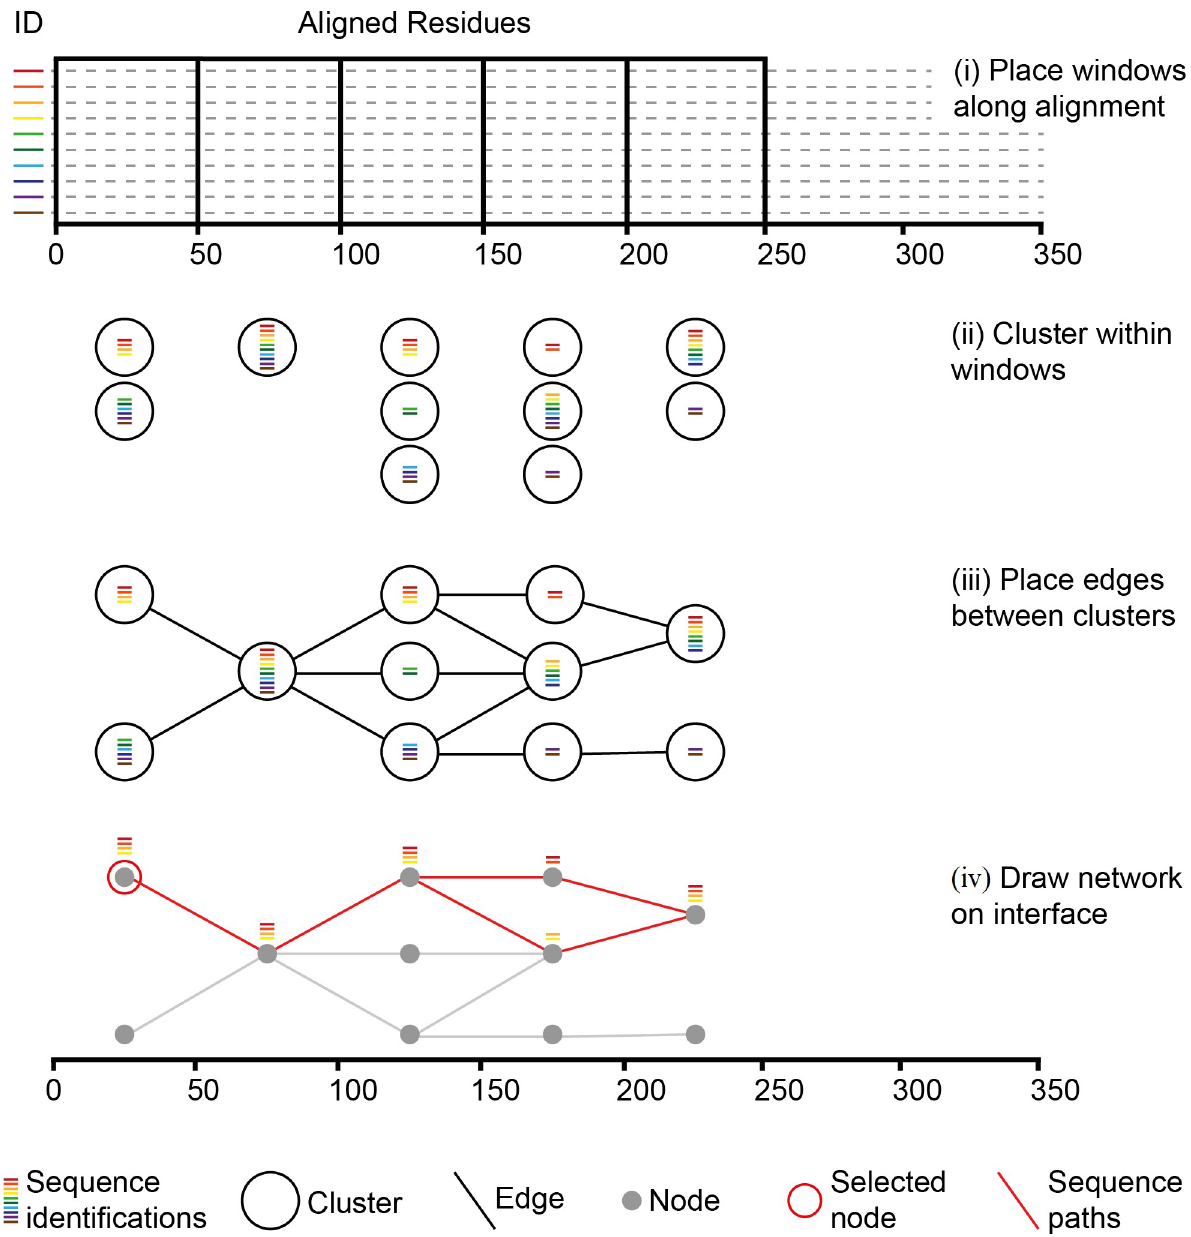
Fig 2. Network construction. Coloured bars indicate unique sequence id’s relative to the corresponding sequences (dotted lines). Within each window the identification representing each full sequence are associated with individual sequence fragments spanning that window (i), and fragments within windows are clustered (ii). Edges are placed between neighbouring clusters where they share one or more sequence identification, i.e. differing regions of the same sequence (iii). Clusters are represented visually on the network by grey dots. If a single cluster is selected the paths of all sequences passing through in relation to all other clusters (red lines) can be traced